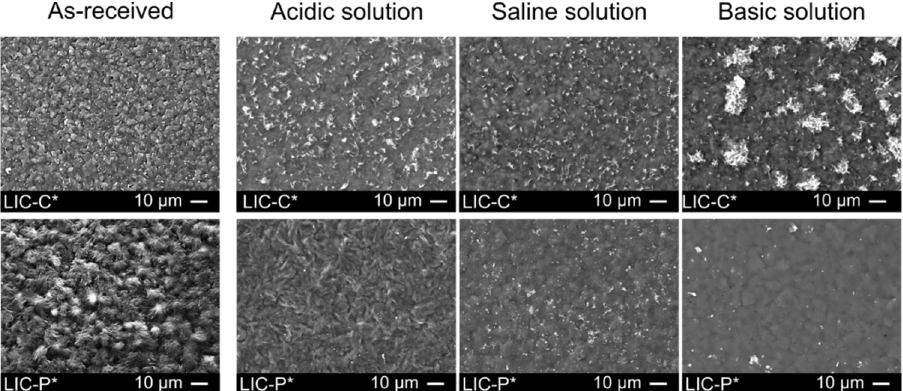
Figure 12. Micrographs of the surface morphologies of LICs after 60 days of immersion in acidic, saline, and basic solutions.